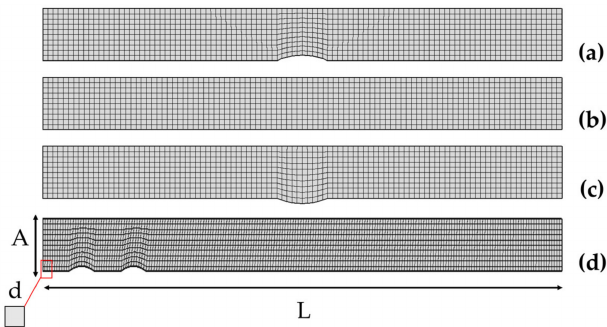
Figure 2. Geometry meshing for the bumped ( a ), inlaid ( b ), recessed ( c ), and two bumped electrodes ( d ) configurations. The channel length is represented by the L parameter, while the channel height is represented by the parameter A. The size of the square meshing elements is described in term of the mesh edge size